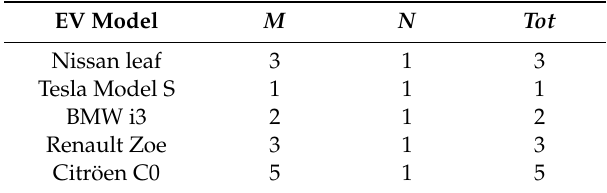
Table 6. Sizing of dedicated I-Life ESS for CSs by using di ff erent battery packs.